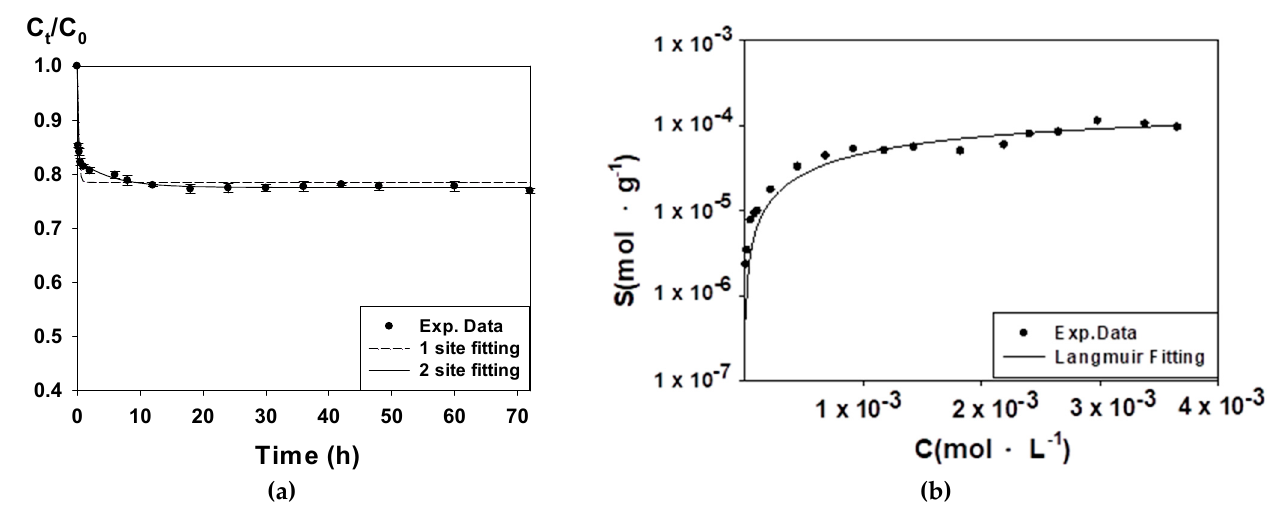
Figure 2. Sorption of Se on TMS clay: ( a ) kinetic sorption tests; ( b ) Langmuir isotherm. Table 2. Model fitting parameters for sorption of Se on TMS clay.